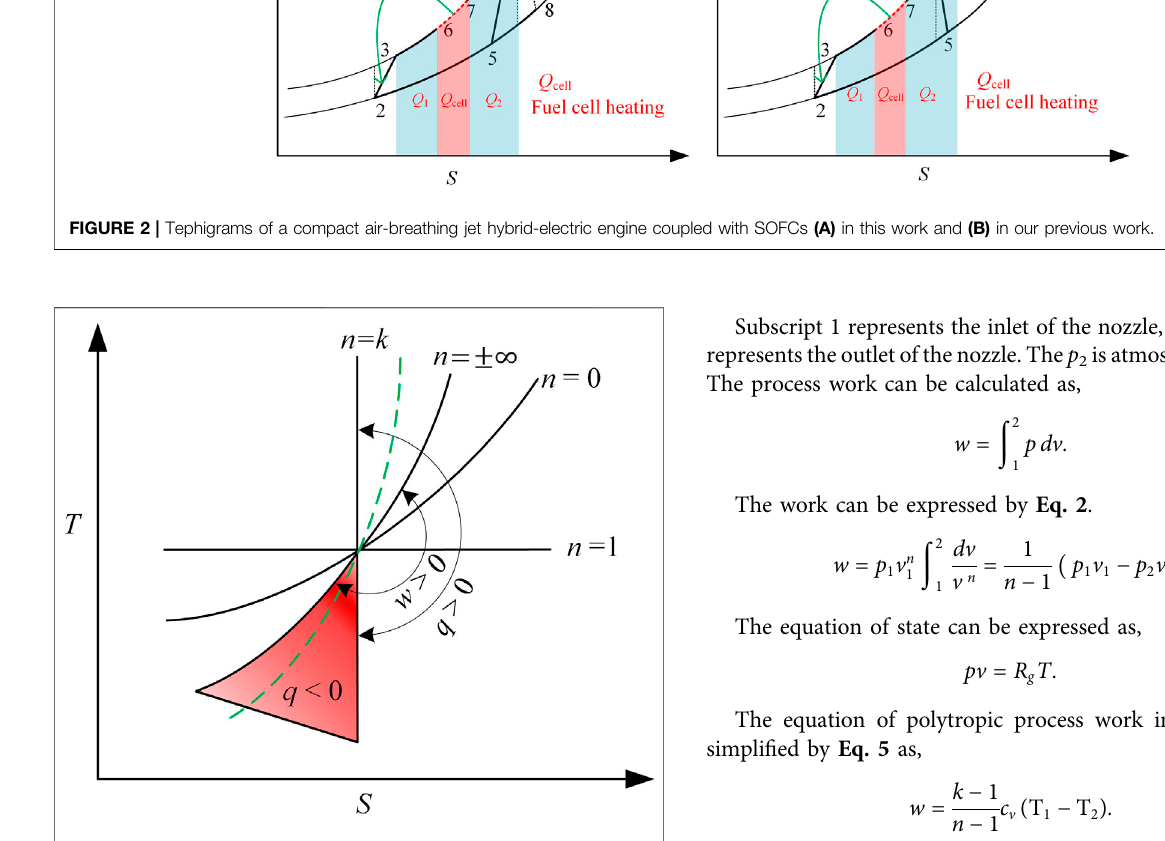
FIGURE 3 | Tephigrams of polytropic thermal